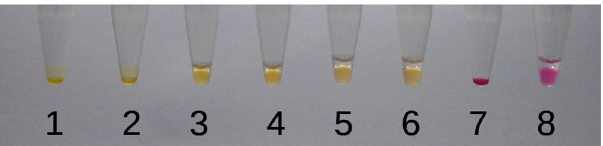
Figure 5. Effect of the mineral oil after amplification at 67 °C for 60 min. In tubes 1, 2, and 7 there was no addition of the mineral oil; tubes 3 and 4 received 5 μL of mineral oil, and tubes 5, 6, and 8 received 10 μL of mineral oil. Tubes 1–6 received SARS-CoV-2 positive control and tubes 7 and 8 were negative